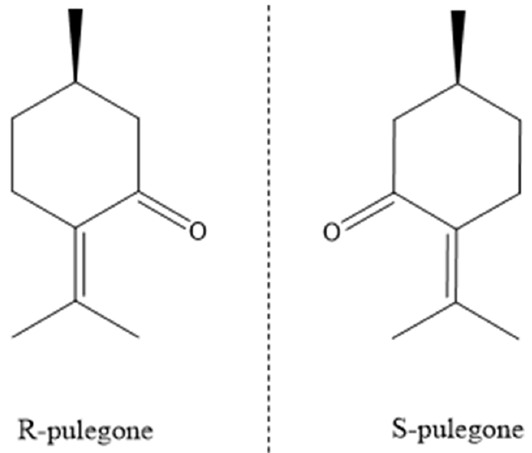
Figure 1. Structure of the two enantiomers of pulegone.